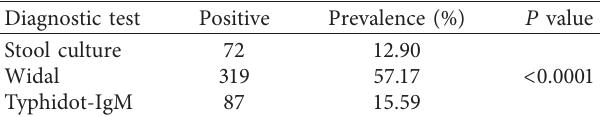
Table 5: Prevalence of typhoid fever based on the index and reference test